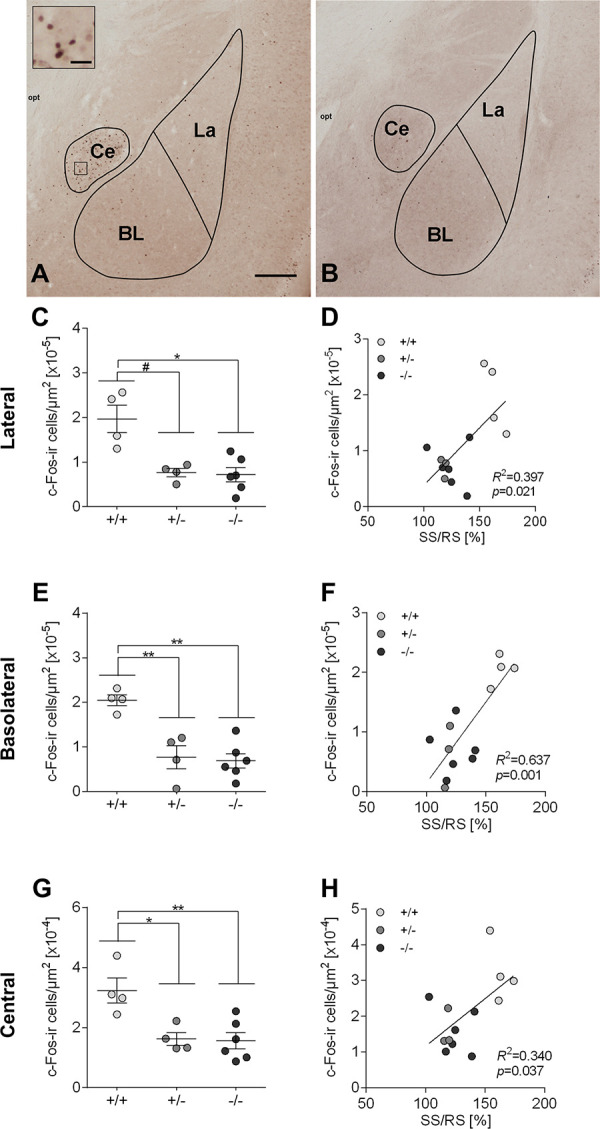
The density of c-Fos-immunoreactive cells in three amygdaloid nuclei, which is influenced by 5-Htt genotype, correlates with the percental signal change from resting state to stimulation state.(A,B): Representative image of c-Fos immunostaining in a brain section of a male mouse, which received the aversive odor (A) or the neutral odor (B) during fMRI experiment. c-Fos-ir cells are discernible by means of a clear brown nucleus staining. Scale bar in A represents 250 μm for A and B, and 25 μm in the inset in A. Lateral nucleus, La; basolateral nucleus, BL; central nucleus, Ce. (C,E,G): Data points represent individual and mean± SEM density of c-Fos-immunoreactive cells (number of c-Fos-ir cells per μm2) in the lateral, basolateral and central amygdaloid nucleus of male mice with aversive odor exposure; Statistical analysis was performed using one-way ANOVA and Bonferroni post hoc tests were applied for pairwaise comparisons. As in case of La data the assumption of homogeneity of variance is violated (S1 Table), Welch`s ANOVA was applied and followed by Games-Howell post hoc tests. ** p ≤ 0.01, * p ≤ 0.05, # p ≤ 0.1. (D,F,H): Data points represent c-Fos-ir cell density and SS/RS. correlations are significant in the lateral (D) and in the basolateral (F), but not in the central nucleus (H) of the amygdala.